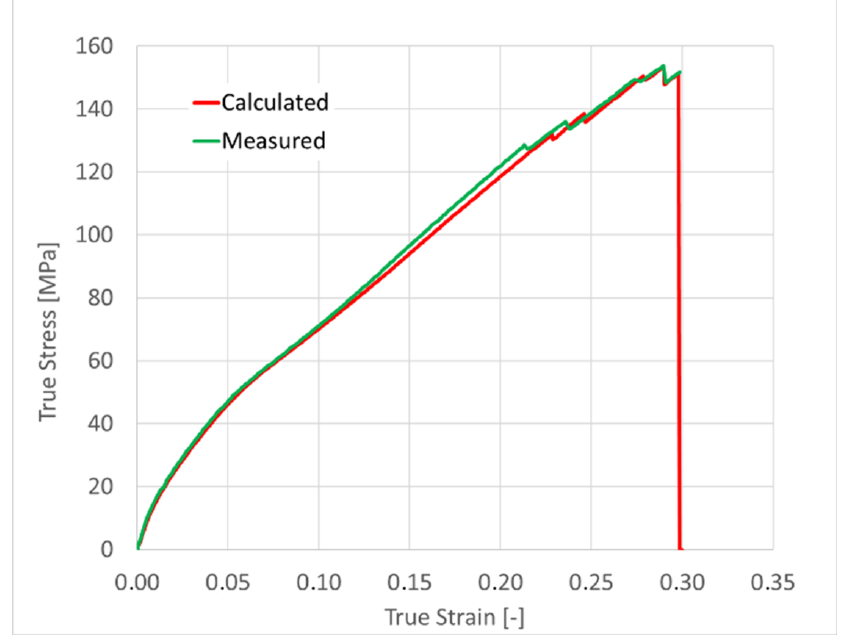
Figure 7. Comparison between DIC (green) and classical measurements (red) of the true stress vs. true strain curve in the MD direction.